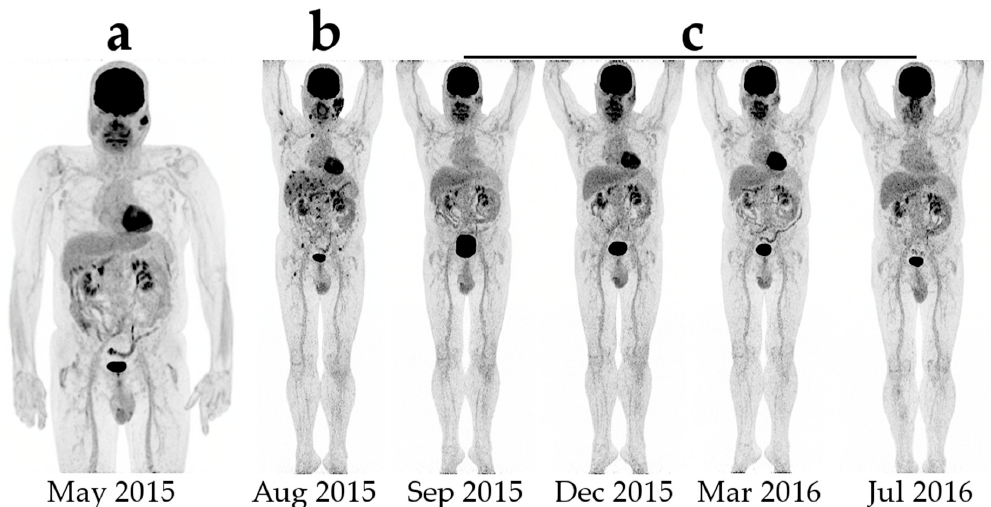
Figure 1. Example of early pseudoprogression in a patient with malignant melanoma: ( a ) initial Positron Emission Tomography/Computer Tomography with 18 F-Fluorodeoxyglucose; ( b ) first evaluation after four series of ipilimumab shows multiple new foci in the liver and the bones with highly increased LDH (lactate dehydrogenase); and ( c ) subsequent scans after completion of treatment showing complete disappearance of both new foci and the primary lesions.